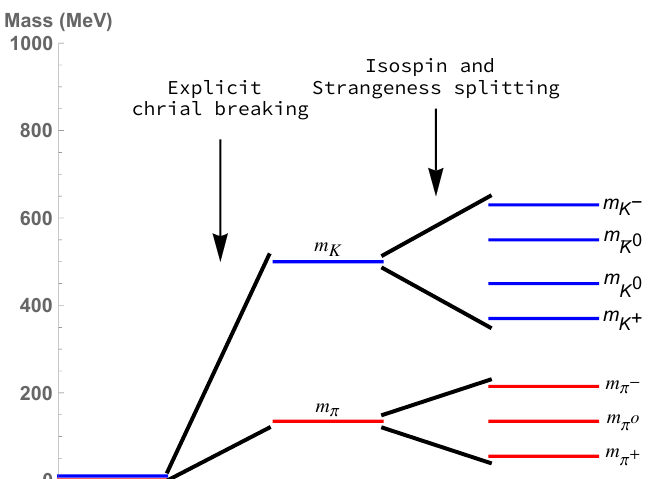
Figure 4. Sketch of the energy levels of pions and kaons. On the left we assume massless quarks and vanishing chemical potentials. The effect of the explicit symmetry breaking induced by the quark masses is shown in the central region. On the right we show the mass splitting within isomultiplets, obtained for µ I = 80 MeV and µ S = 90 MeV. The isospin and the strangeness chemical potentials completely remove the level